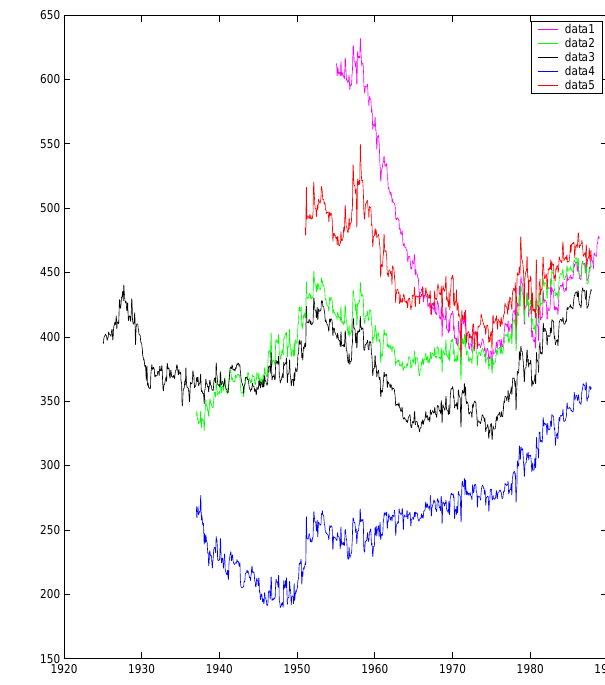
Fig. 9. Amplitude of the 12-month line, A 12 (t) , for (1) CLF (2) HAD (3) ESK(4) LER (5) SIT. Vertical unit: .35 10 − 3